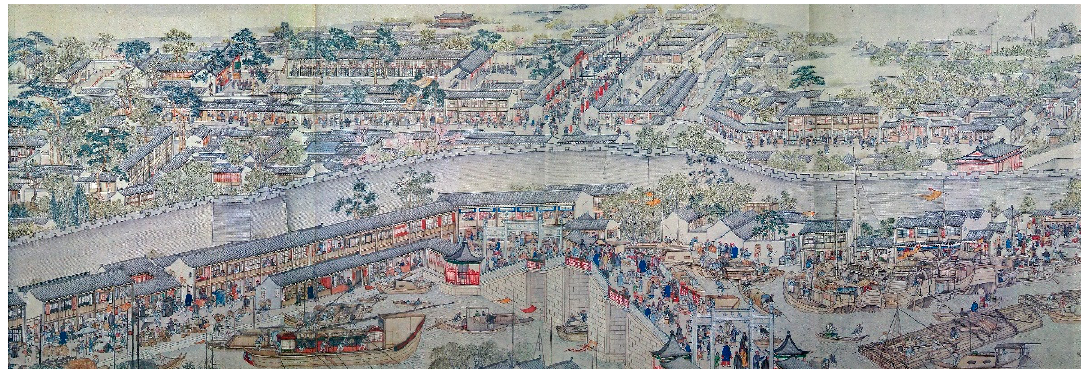
Figure 10. Scenes at Wangnian Bridge and the canals around it described in Suzhou’s Golden Age [65].